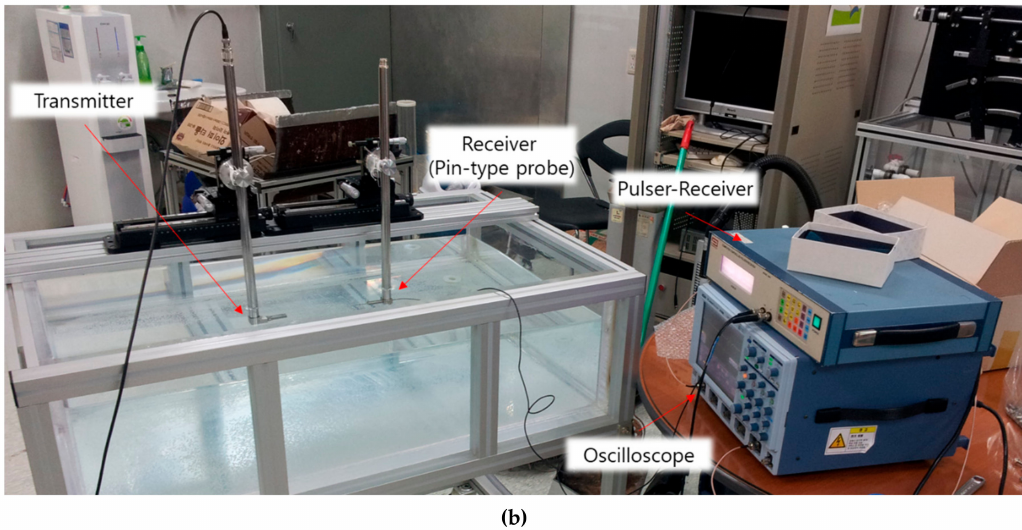
Figure 8. ( a ) Schematic illustration and ( b ) photograph of the experimental setup for the coupon specimen using the through-transmission method.